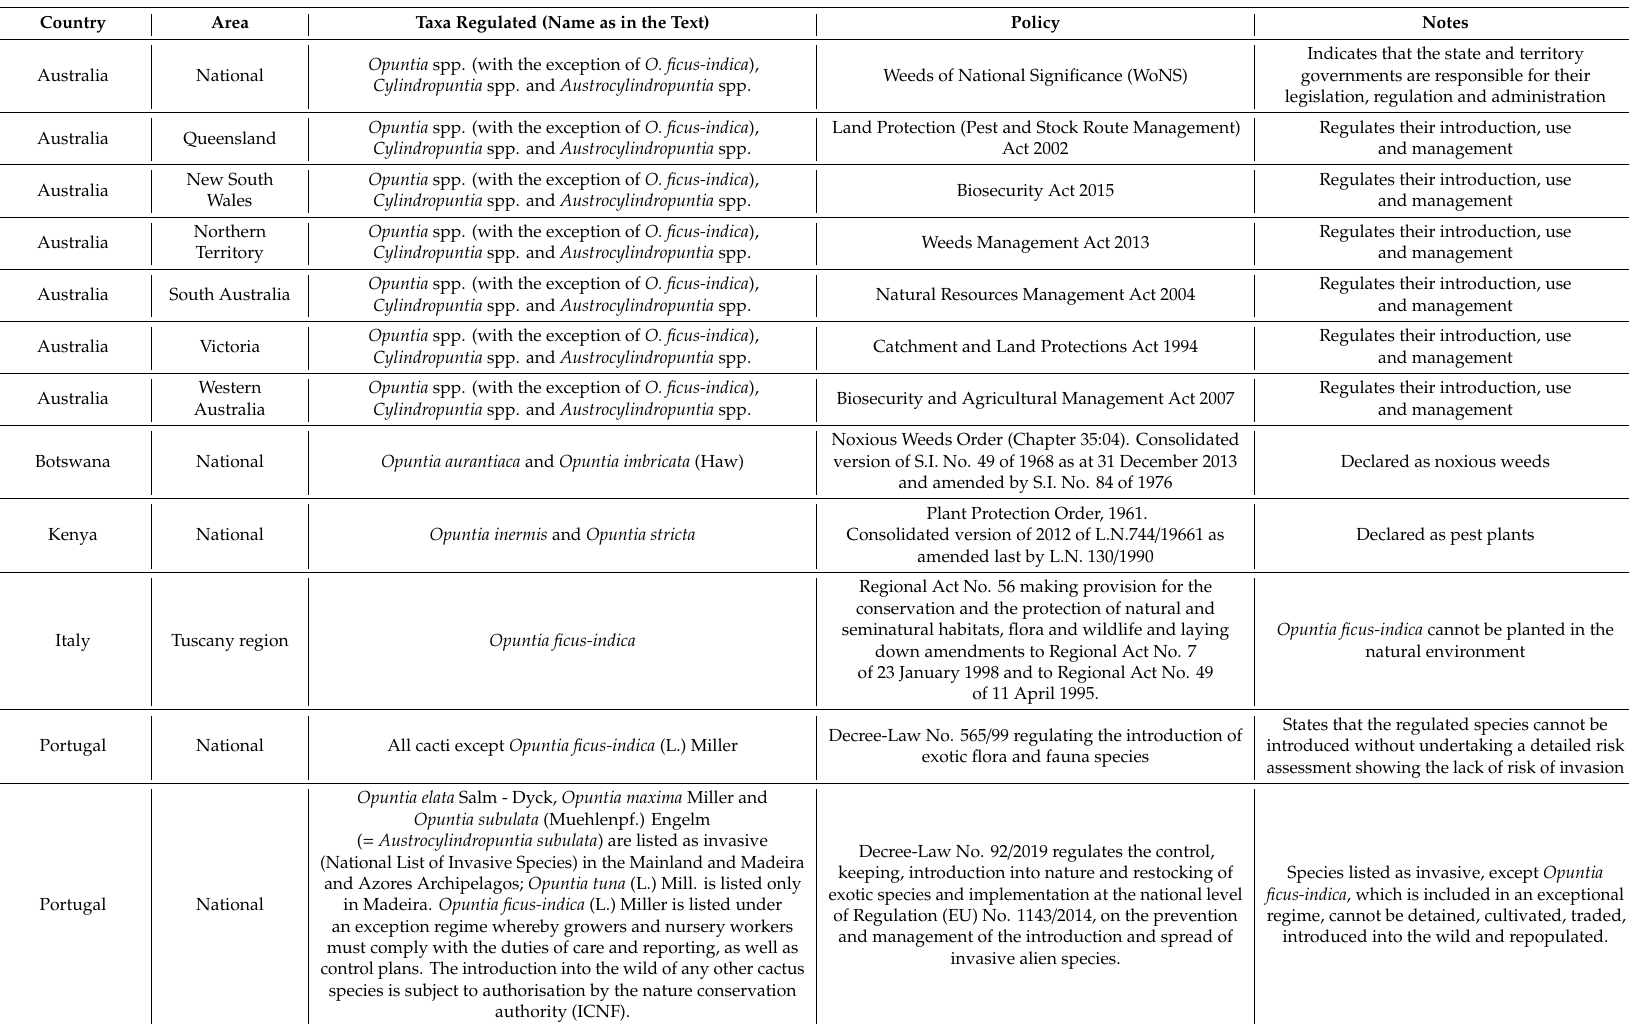
Table 2. Examples of policies regulating the introduction and use of cactus species in a number of